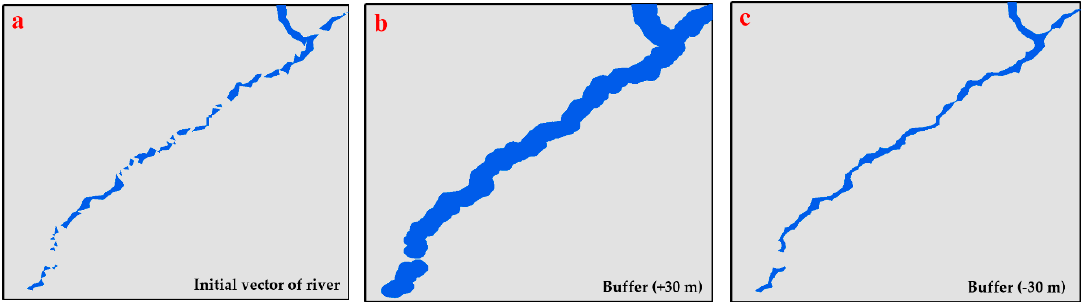
Figure 5. Connectivity processing of disconnected rivers. ( a ) Disconnected river extraction from Sentinel-2 images; ( b ) bu ff ering result of 30 m of outward expanding of ( a ); ( c ) bu ff ering result of 30 m inward contracting of (b).